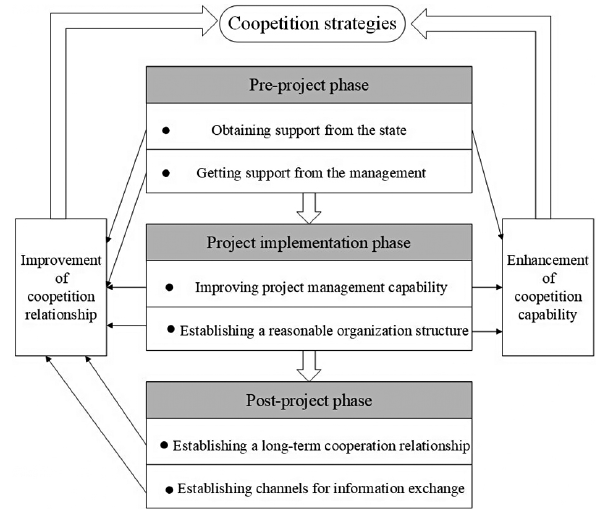
Figure 4. Application of the path model